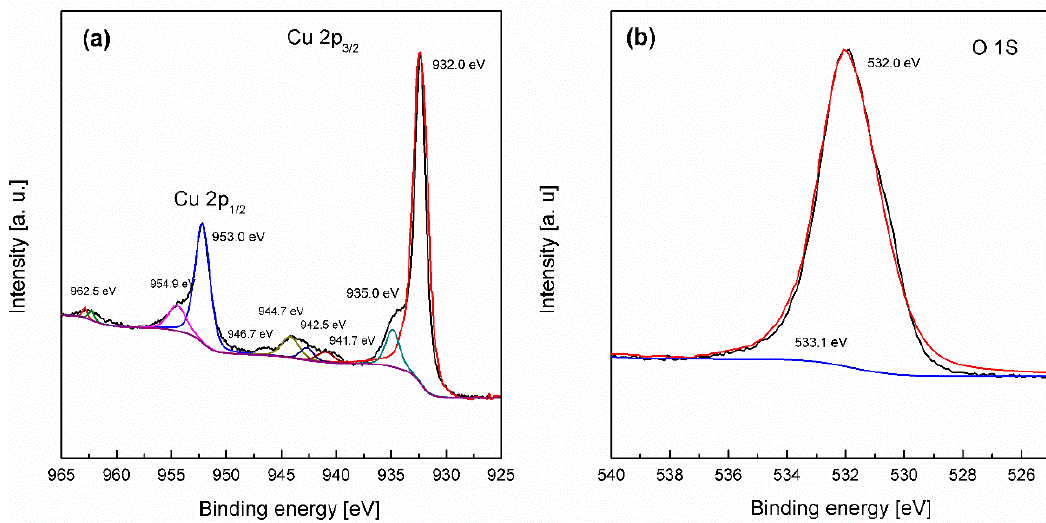
Figure 3. X-ray photoelectron spectroscopy (XPS) spectra for ( a ) Cu 2p 3/2 and ( b ) O 1s for a Cu foil electrode restructured in 1 M NaOH containing 1 M ethanol at 10 mV s − 1 for 20 cycles over the potential range of − 1.5 to 0.50 V.